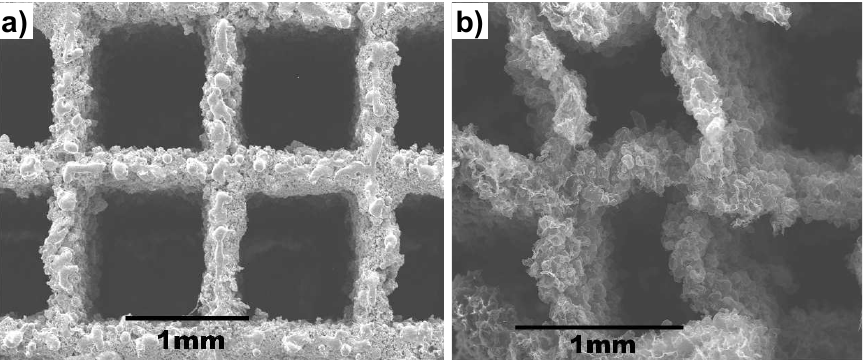
Figure 4. SEM image of the ( a ) as-synthesized 3D-printed Ni scaffold; ( b ) free-standing 3D graphene networks. Reprinted with permission from ref. [25]. Copyright 2015 The Royal Society of Chemistry.